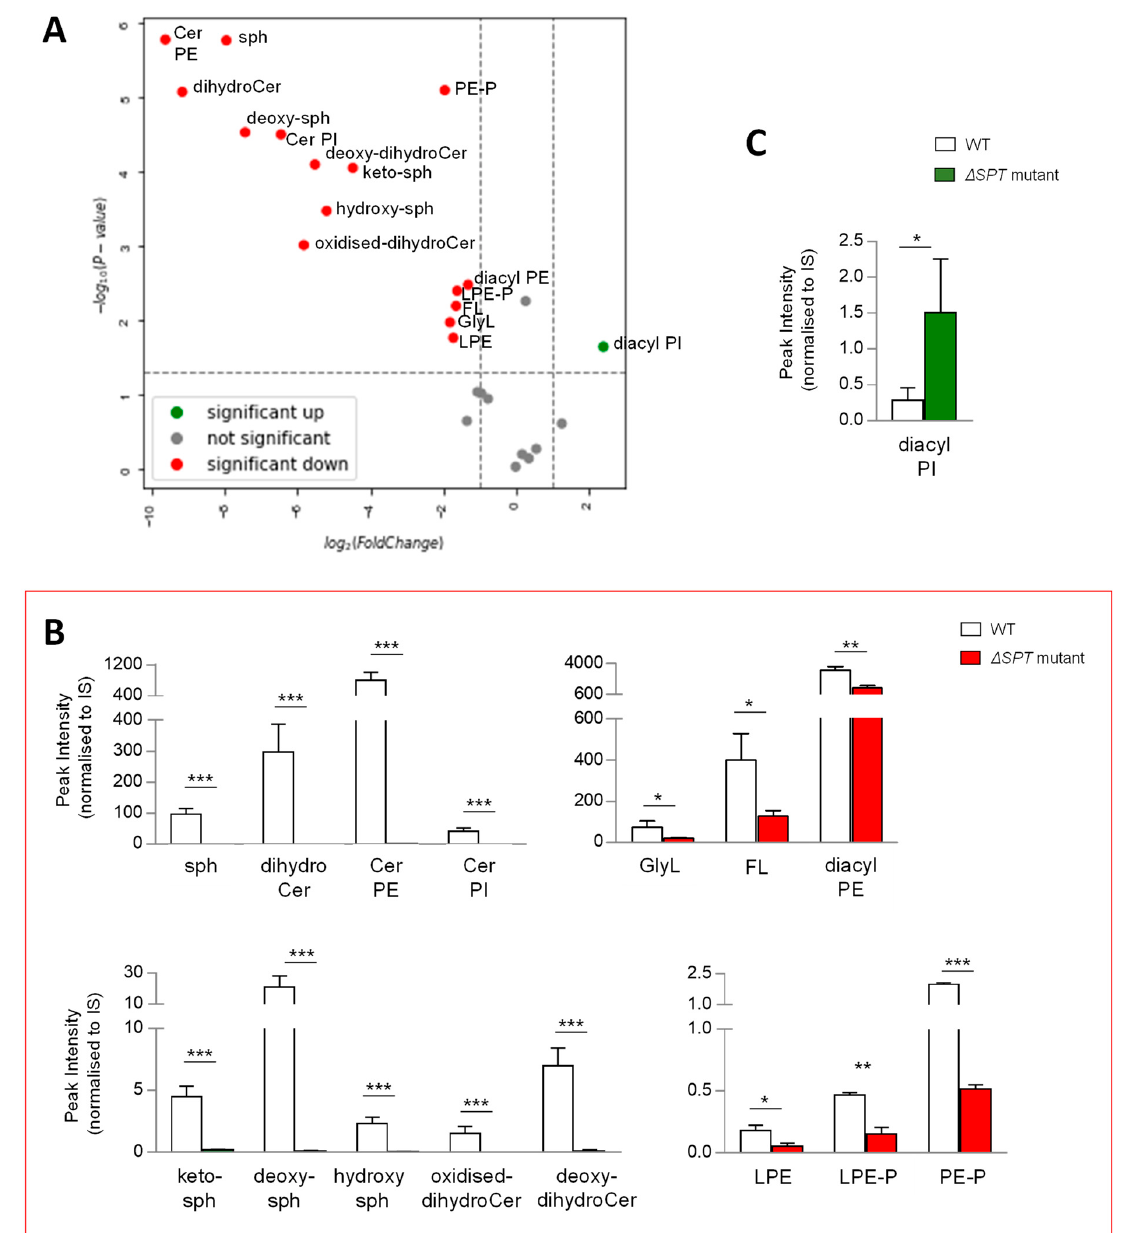
Figure 5. A mutation in sphingolipid (SP) biosynthesis ( ∆ SPT mutant) results in significant changes in the lipid signature of B. thetaiotaomicron. ( A ) Univariate analyses (volcano plot) reveal significant changes (>2 fold, t-test p -value < 0.05) to the lipid profile of B. thetaiotaomicron; 15 of the 26 lipid ‘subgroups’ were significantly reduced (depicted in red) in the ∆ SPT mutant relative to the WT parent, 1 ‘subgroup’ was significantly increased (depicted in green), whilst 10 ‘subgroups’ were either unchanged or not detected (depicted in grey). ( B ) The SP ‘subgroups’ detected in WT B. thetaiotaomicron were completely depleted in ∆ SPT mutant extracts. Significantly decreased lipids were glycine lipids (GlyL) and flavolipins (FL) as well as both lyso- (L) and di- (diacyl) acylated glycerophosphoethanolamines (PE) and their respective plasmalogens (P). ( C ) Diacyl glycerophos- phoinoistols (PI) were the only significantly decreased lipid ‘subgroup’ related to ∆ SPT mutation in B. thetaiotaomicron. All data shown are represented as mean values from n = 3 independent experiments. Standard deviation (SD) from the mean is indicated. Student T test was applied: *** p < 0.001, ** p < 0.005, * p < 0.05 to log transformed data prior to univariate analyses. The data shown represent area under the curve, untransformed peak intensity